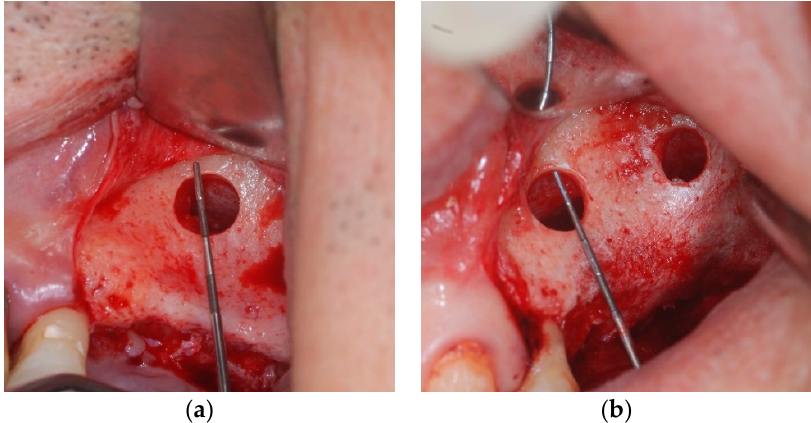
Figure 2. ( a ) Elevated Schneiderian membrane was observed through a minimum-sized lateral window (circular shape with a diameter of 5–6 mm); ( b ) Two minimum-sized lateral windows with a diameter of 5–6 mm were made for proper elevation of Schneiderian membrane.